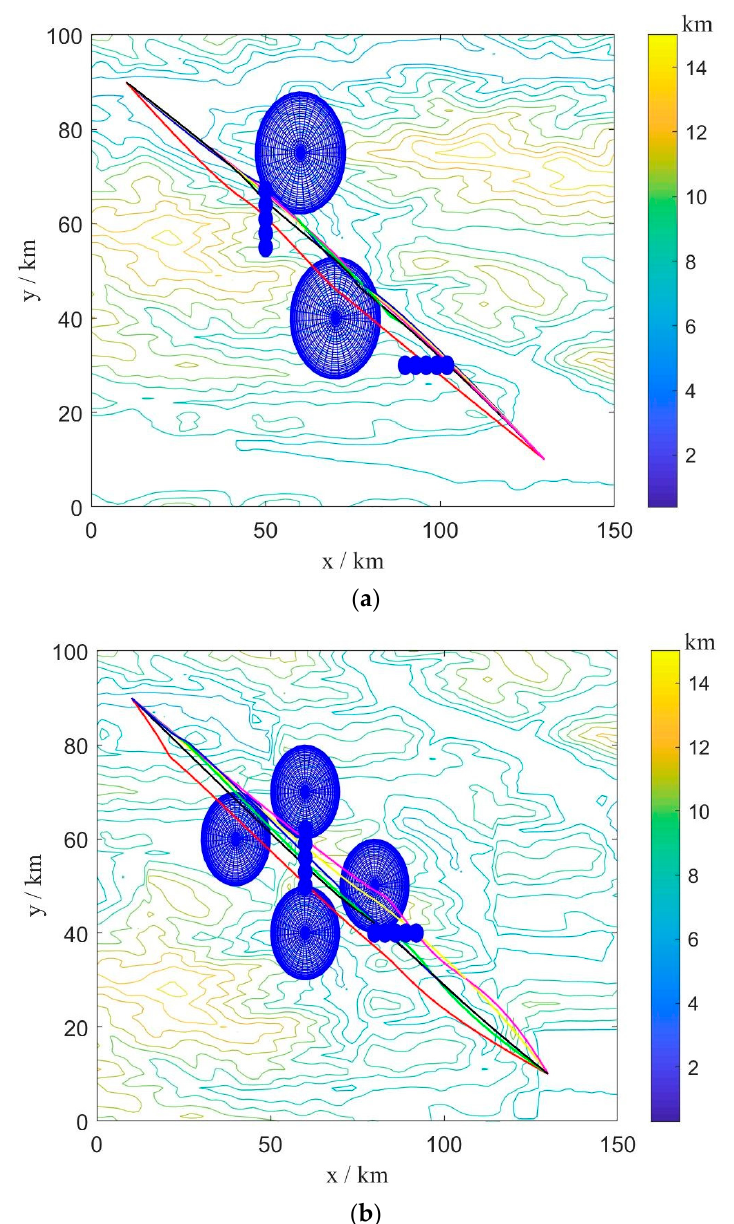
Figure 15. Multi-UAV path planning results of BINN-HHO on a 2D simulation map. ( a ) Dynamic case I. ( b ) Dynamic case II.